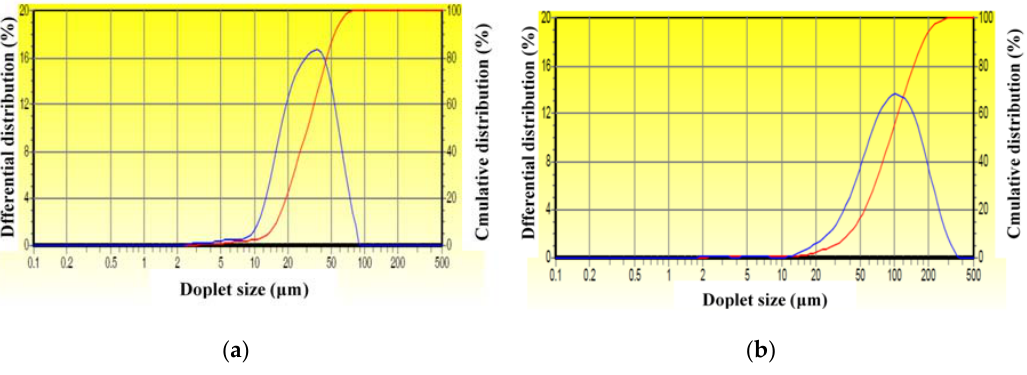
Figure 4. The droplet size distribution of emulsified heavy oil: ( a ) without using drag ‐ reducing surfactant; ( b ) using drag ‐ reducing surfactant (100 mg/L).